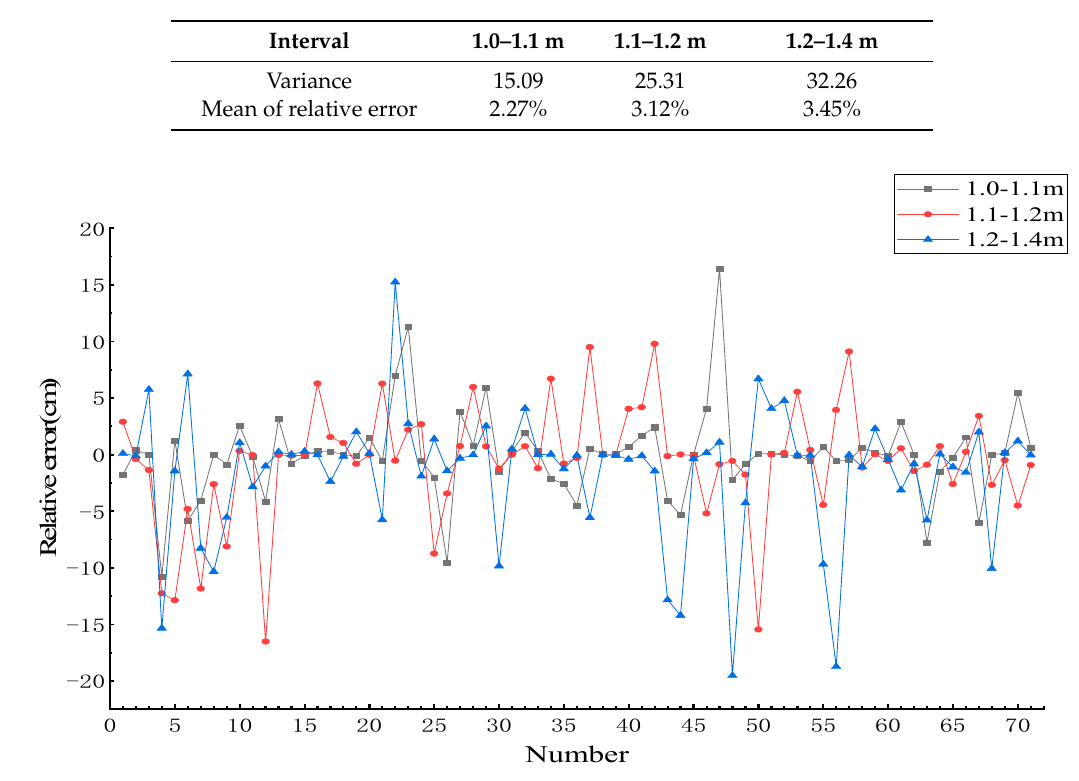
Figure 11. Distribution of relative errors in different intervals.